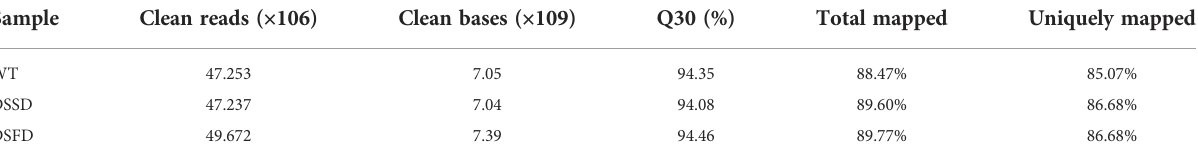
TABLE 2 Summary of mRNA sequencing